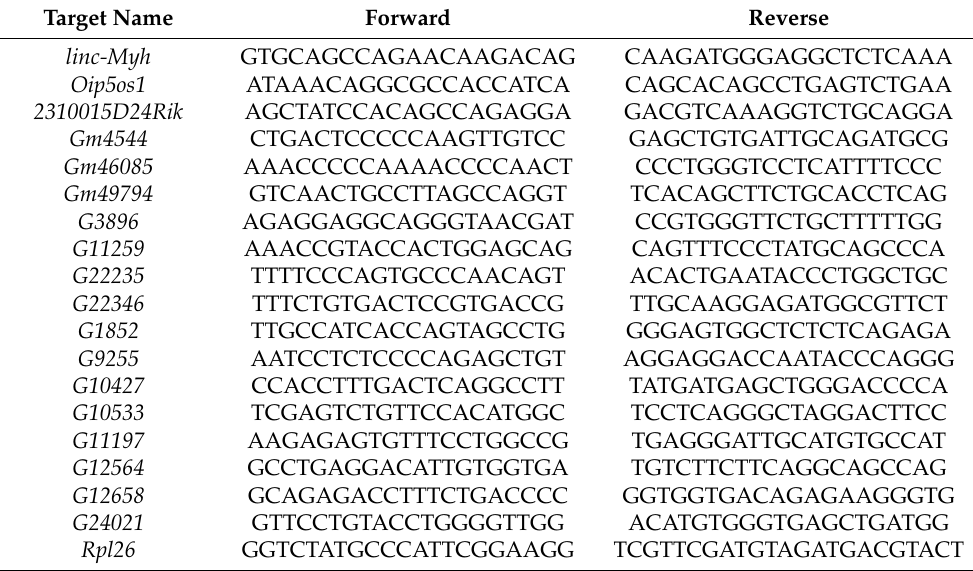
Table 1. Primer sequences used for quantitative